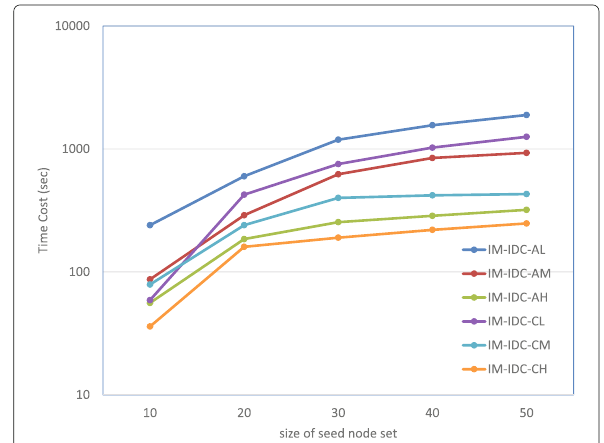
Fig. 7 The running time costs of A PPRO IM-IDC on LiveJournal data while increasing the size of seed